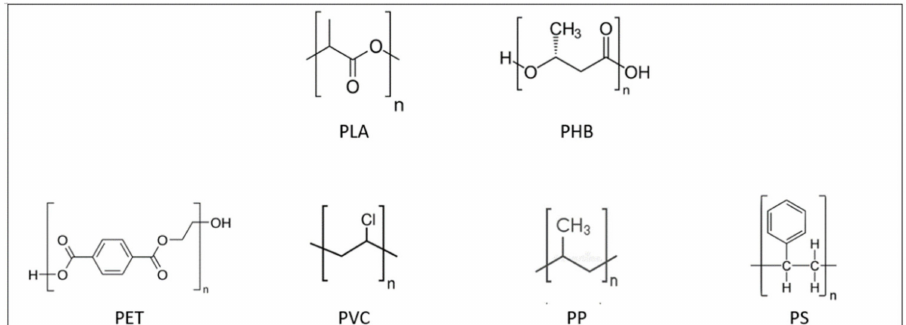
Figure 3. Chemical structures of biodegradable: Polylactic acid (PLA) and polyhydroxybutyrate PHB); and nonbiodegradable polymers: Polyethene terephatalate (PET), polyvinyl chloride (PVC), polypropylene (PP), polystyrene